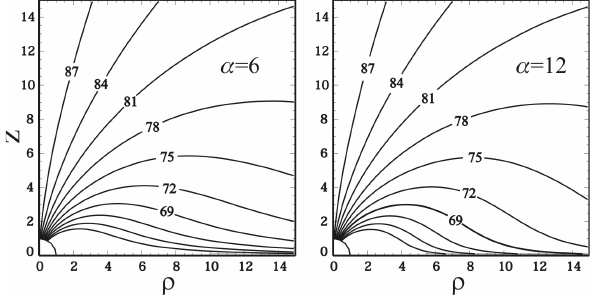
Fig. 3. Meridional sections of the axisymmetric surfaces given by Fig.3. MeridionalsectionsoftheaxisymmetricsurfacesgivenbyEqs.(21)–(22)fortwovaluesofparameter α . Eqs. (21)–(22) for two values of parameter α . The lines are labeled Thelinesarelabeledbyvaluesofthefootpointlatitudeindegrees. by values of the footpoint latitude in surface ξ ( r,θ,φ )=0 aswellastheazimuthaldistributionoftheFACdensity. Radiallyindependent potentials with ∂χ/∂r =0 correspond to purely poloidal currents, flowing in the meridional planes φ = const . Introducingaradialvariationin χ addsanazimuthalcomponentto j ,whichcanbeused 410 tomakethenightsideFACseitherexitthemagnetosphereviaitsflanksorcloseacrossthemidnight meridian. ThemethodoutlinedabovewasusedtoconstructaflexibleR1FACmoduleintheT96model(the firstonetoexplicitlyincludetheFACcontribution),aswellasinmorerecentT02,TS05,andTS07 models. IntheT96model,thesecondpotentialwasassumedintheform 415 where the radial G ( r ) and azimuthal f ( φ ) factors were a priori defined to make the distant FACs enterandexitthemagnetosphereviaitsthedawnwardandduskwardflanks,andtoplacetheduskside and dawnside peaks of the low-altitude FACs closer to the noon meridian. Upon having defined the spatial distribution of FACs, their magnetic field was computed by Biot-Savart integration in the 420 entire modeled region of the magnetosphere, then individually approximated by suitable potential fields in the high-latitude and low-latitude current-free domains, and finally, interpolated across the transitionregions(FACsheets)separatingthesedomains.